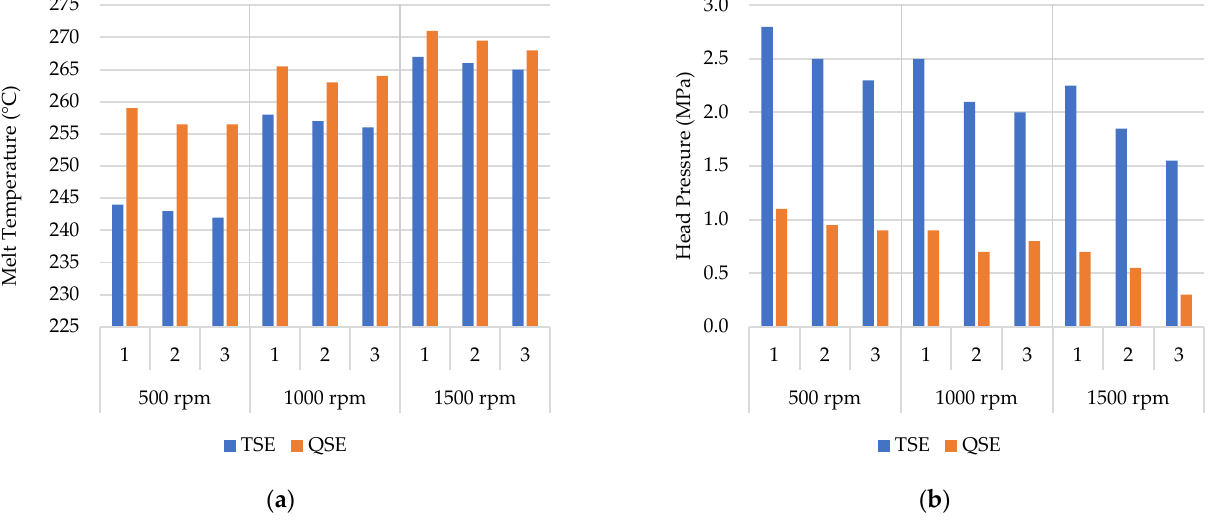
Figure 2. The effect of screw speed and reprocessing cycle (1–3) on the ( a ) melt temperature and ( b ) head pressure developed in the TSE and QSE.